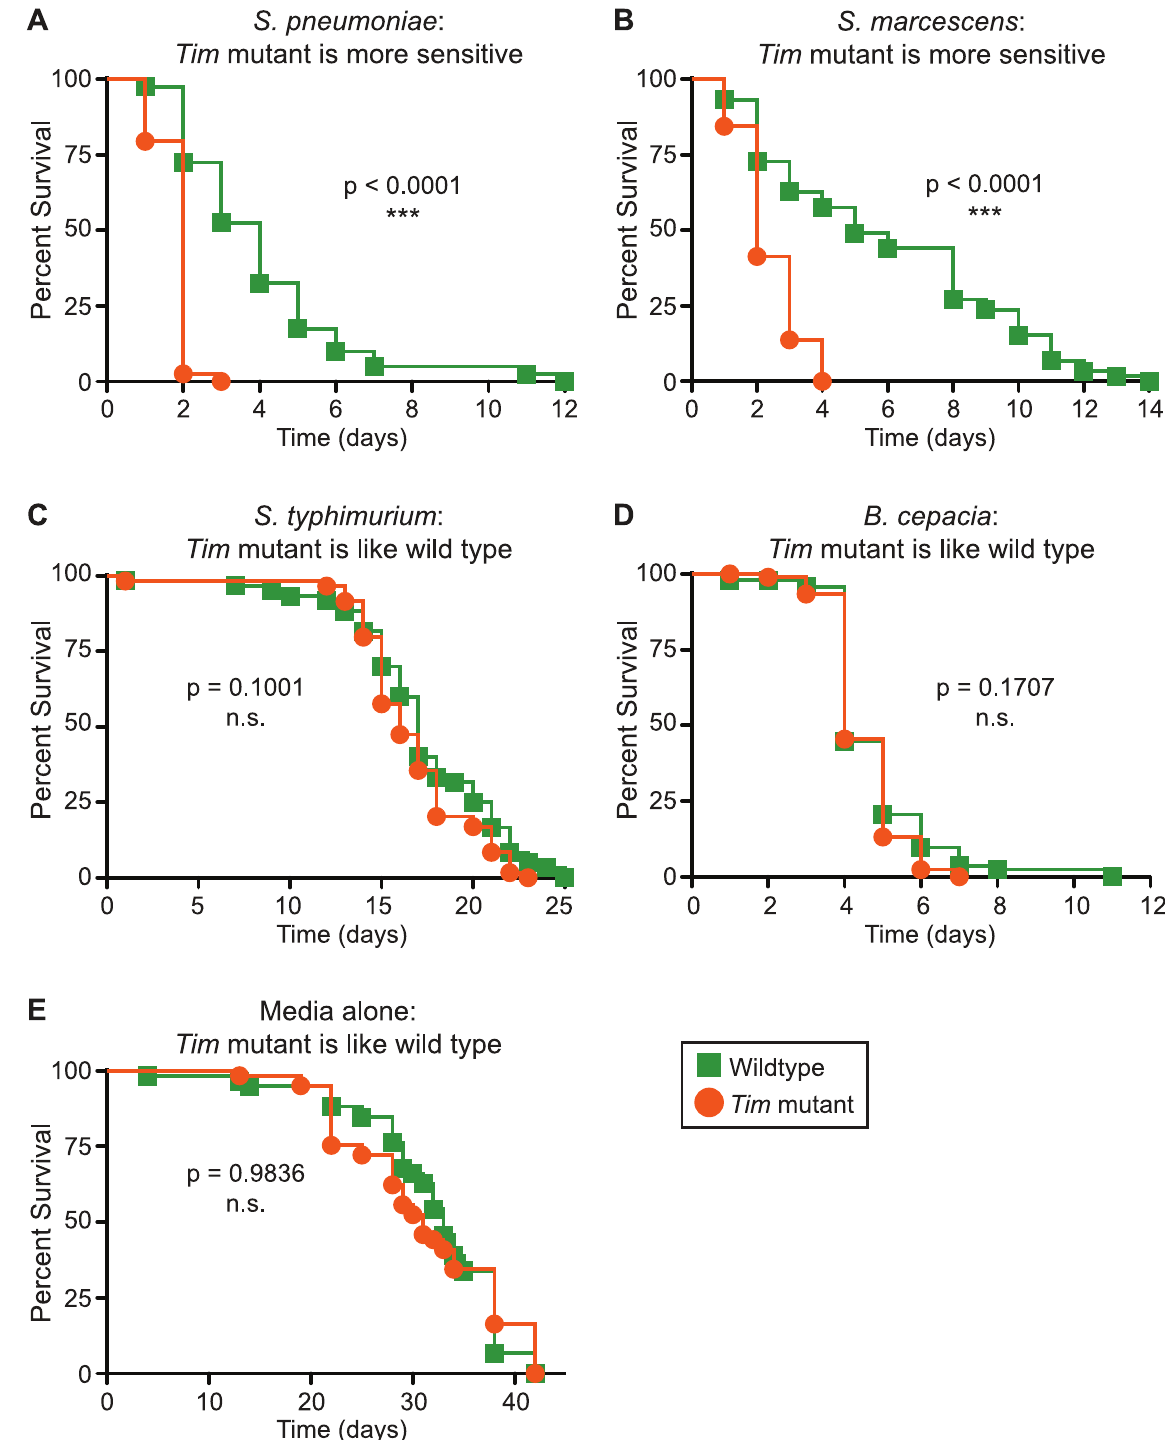
Figure 1. Tim activity has significant consequences for immunity. Shown here are Kaplan-Meier survival curves comparing Tim null mutants (orange circles) and wild-type control flies (green squares). Tim mutants die more quickly after infection with (A) S. pneumoniae (p , 0.0001) or (B) S. marcescens (p , 0.0001). Tim mutants die at the same rate as wild-type flies after infection with (C) B. cepacia (p=0.1001), (D) S. typhimurium (p=0.1707), or (E) medium alone (p=0.9836). p-values were obtained by log-rank analysis.